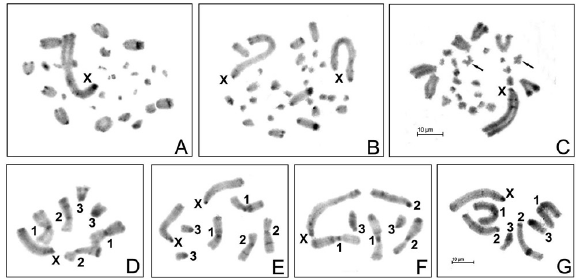
Fig 22. C-banded mitotic metaphase of male complement of G. maculata ( A ), female G. immaculata ( B ), male G. furcata sp. n. ( C ) as well as both male ( D , F , G ) and female ( E ) of G. helleri sp. n. Arrows indicate biarmed chromosomes in G. furcata sp. n. ( C ). In G. helleri sp. n. the long polymorphic pair 2 shows three main karyomorphs in which homologous chromosomes differ in their morphology: both meta- or submetacentric ( D, E ), meta/submetacentric : acrocentric ( F ) and both acrocentric ( G ). X, sex chromosome. Scale bar = 10